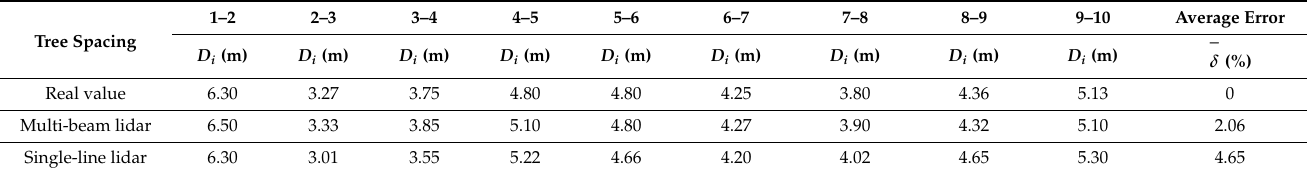
Table 3. Measurement data of a row of trees.